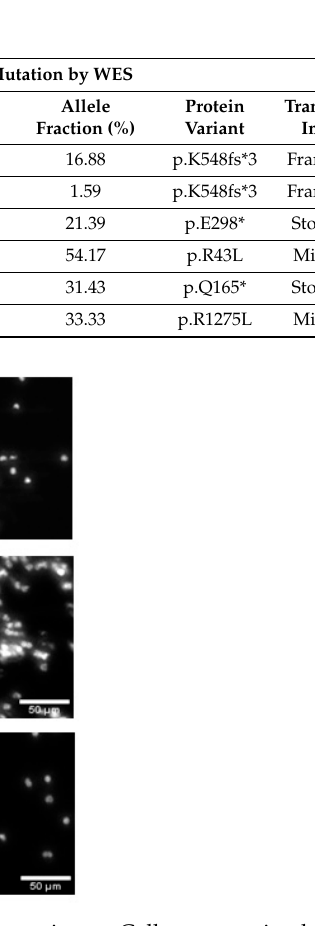
Figure 6. Identification of CTCs for whole exome sequencing (WES). Representative images of identified CTCs from three patients. Cells were stained with fluorophore-conjugated rVAR2 (green), anti-CD45 antibody (magenta) and DAPI (blue) and classified as CTCs if rVAR2+, CD45 − , and DAPI+. Images were obtained using the CellCelector™ (ALS) with a 10× objective. Scale bars, 50 µm.